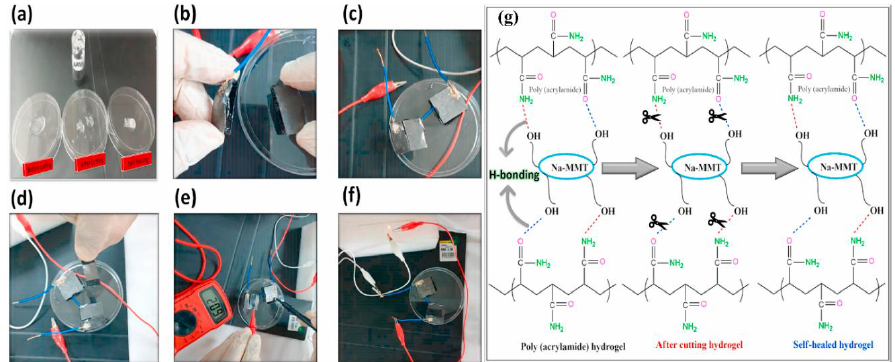
Figure 25. ( a ) AAM3 hydrogel electrolytes before cutting, after cutting, and self-healed; ( b ) supercapacitor after cutting into two pieces; ( c ) rejoining of cut pieces; ( d ) graphite electrode broken ends connected using carbon tape; ( e ) voltage stored after charging; ( f ) discharging of two supercapacitors connected in series through LED. ( g ) Structural illustration of self-healing mechanism in poly (acrylamide) hydrogel [41] .